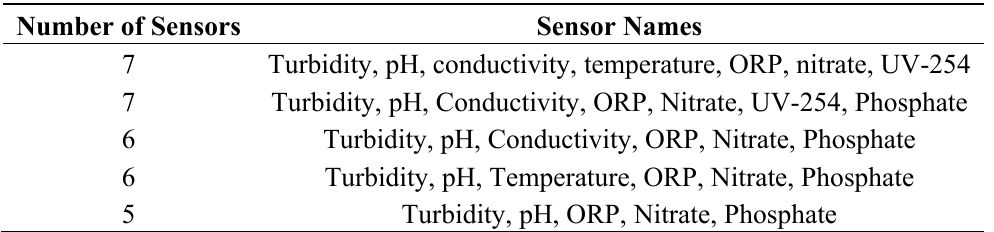
Table 6. Sensors used in each optimal